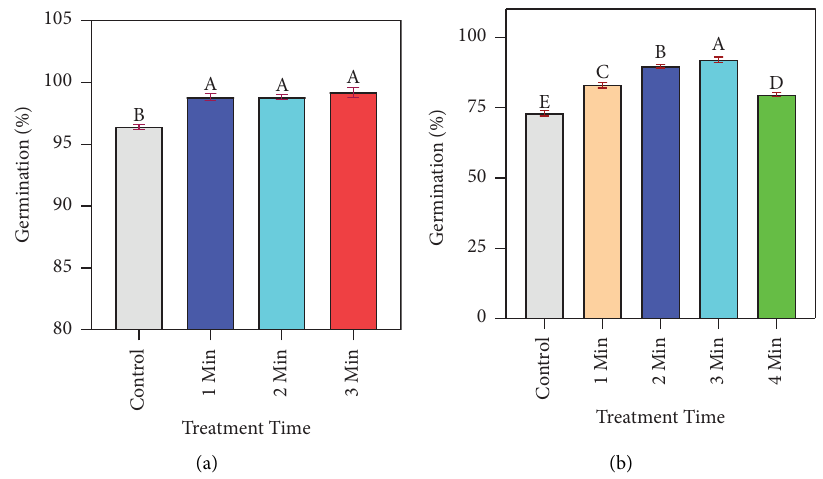
Figure 5: Infuence of CAPP exposure on the germination of (a) radish and (b)